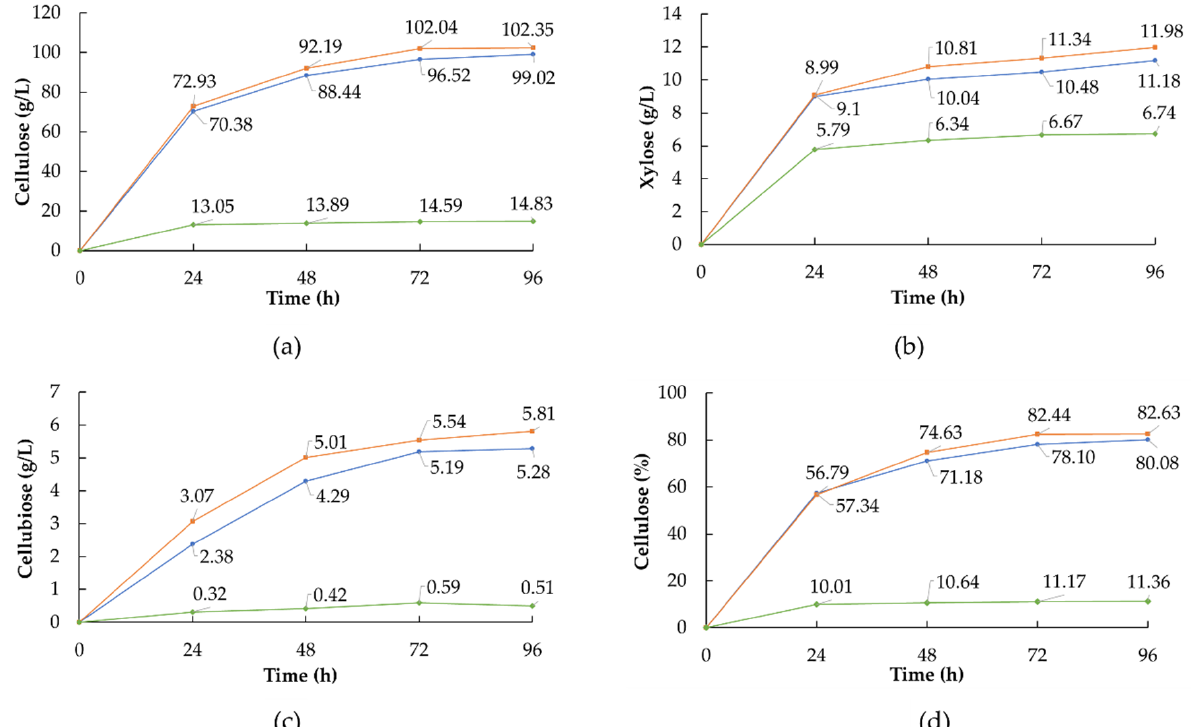
Figure 4. Saccharification process kinetics. ( a ) Glucose concentration (g/L); ( b ) xylose concentration (g/L); ( c ) cellobiose concentration (g/L); ( d ) saccharification yield (%). Data are mean values of triplicate experiments. Correspond at 0 FPU, at 10 FPU, and at 15 FPU.